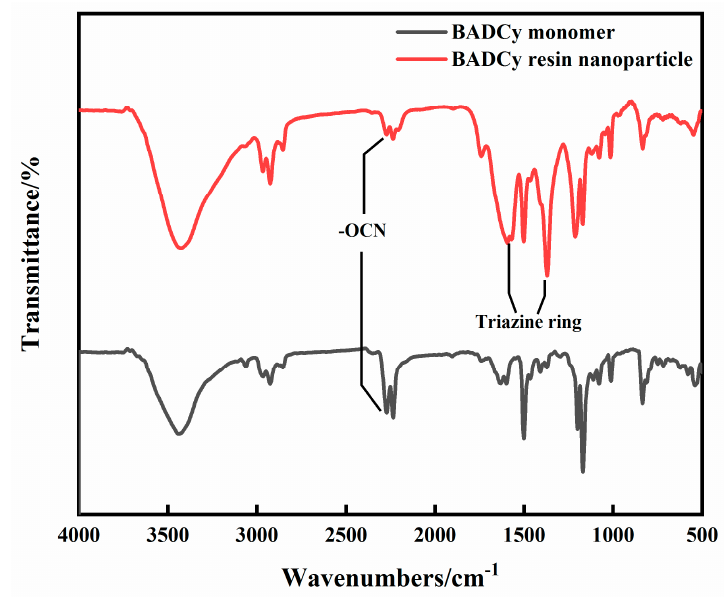
Figure 3. FT-IR of the BADCy monomer and BADCy resin nanoparticle.